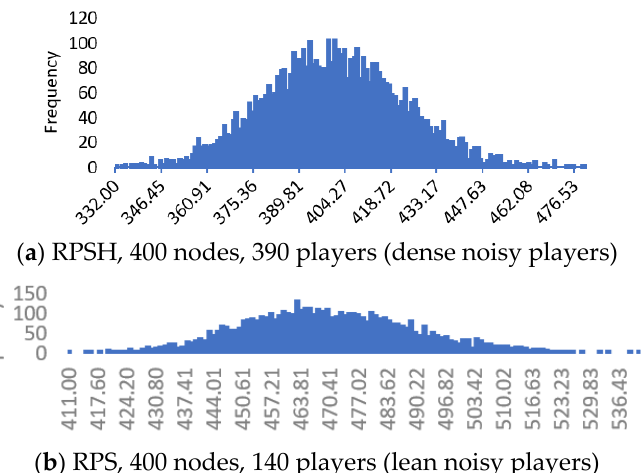
Figure 9. The distribution of moves with RPS and RPSH becomes normal for a large number of nodes with 5000 epochs. The RPSH plot is for 400 nodes with 390 players (densely packed). The mean of RPSH distribution is 400.7 with standard deviation = 21.87. Kurtosis = 0.00245, skewness = 0.105593. Mean of RPS with lean noisy players is 470 with standard deviation = 18.86, kurtosis = − 0.08, skewness = 0.21.